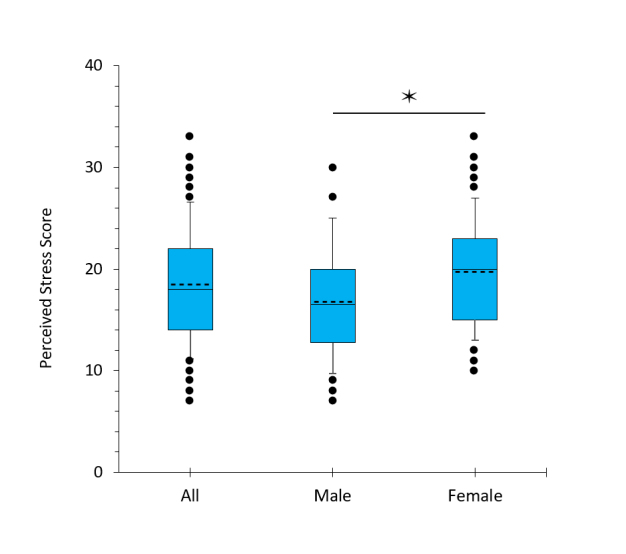
Perceived Stress score in third-year medical students. The mean is indicated by the dotted line. N = 111 for all students; 46 for males, 65 for females. *p = .005 by Student's t-test (t(109) = 2.867).